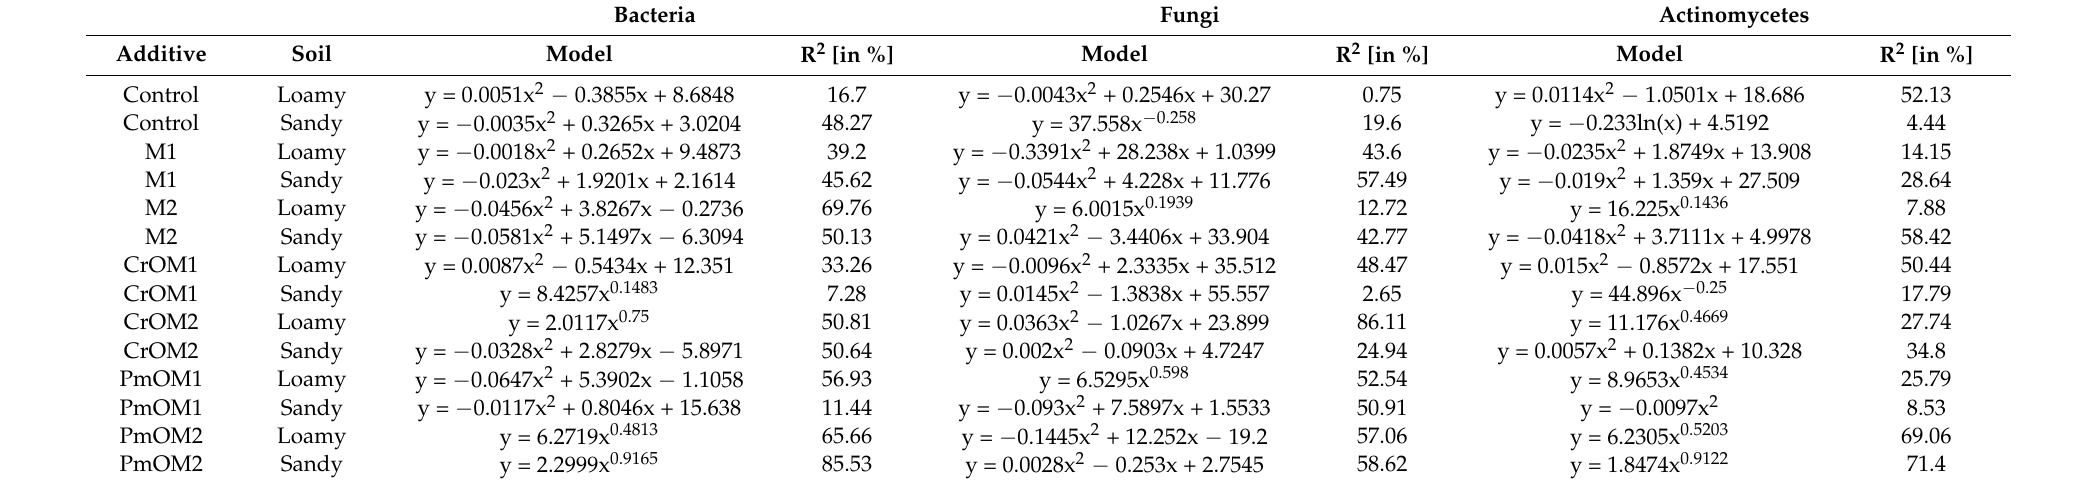
Table 2. The best models for the influence of time (days) after mixing soils with the microencapsulated essential oils (x) on the soil populations of bacteria, fungi, and actinomycetes (y) resulted from the regression